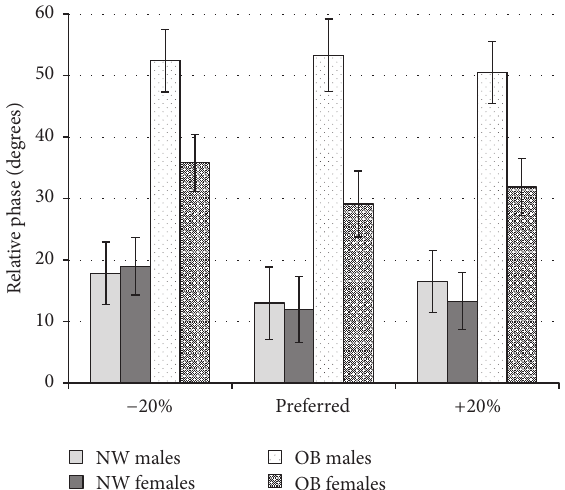
Figure 2: Mean continuous relative phase (CRP) values shown for normal weight (NW) and obese (OB) participants divided by gender for all 3 frequency conditions ( − 20%, preferred frequency, and +20%).